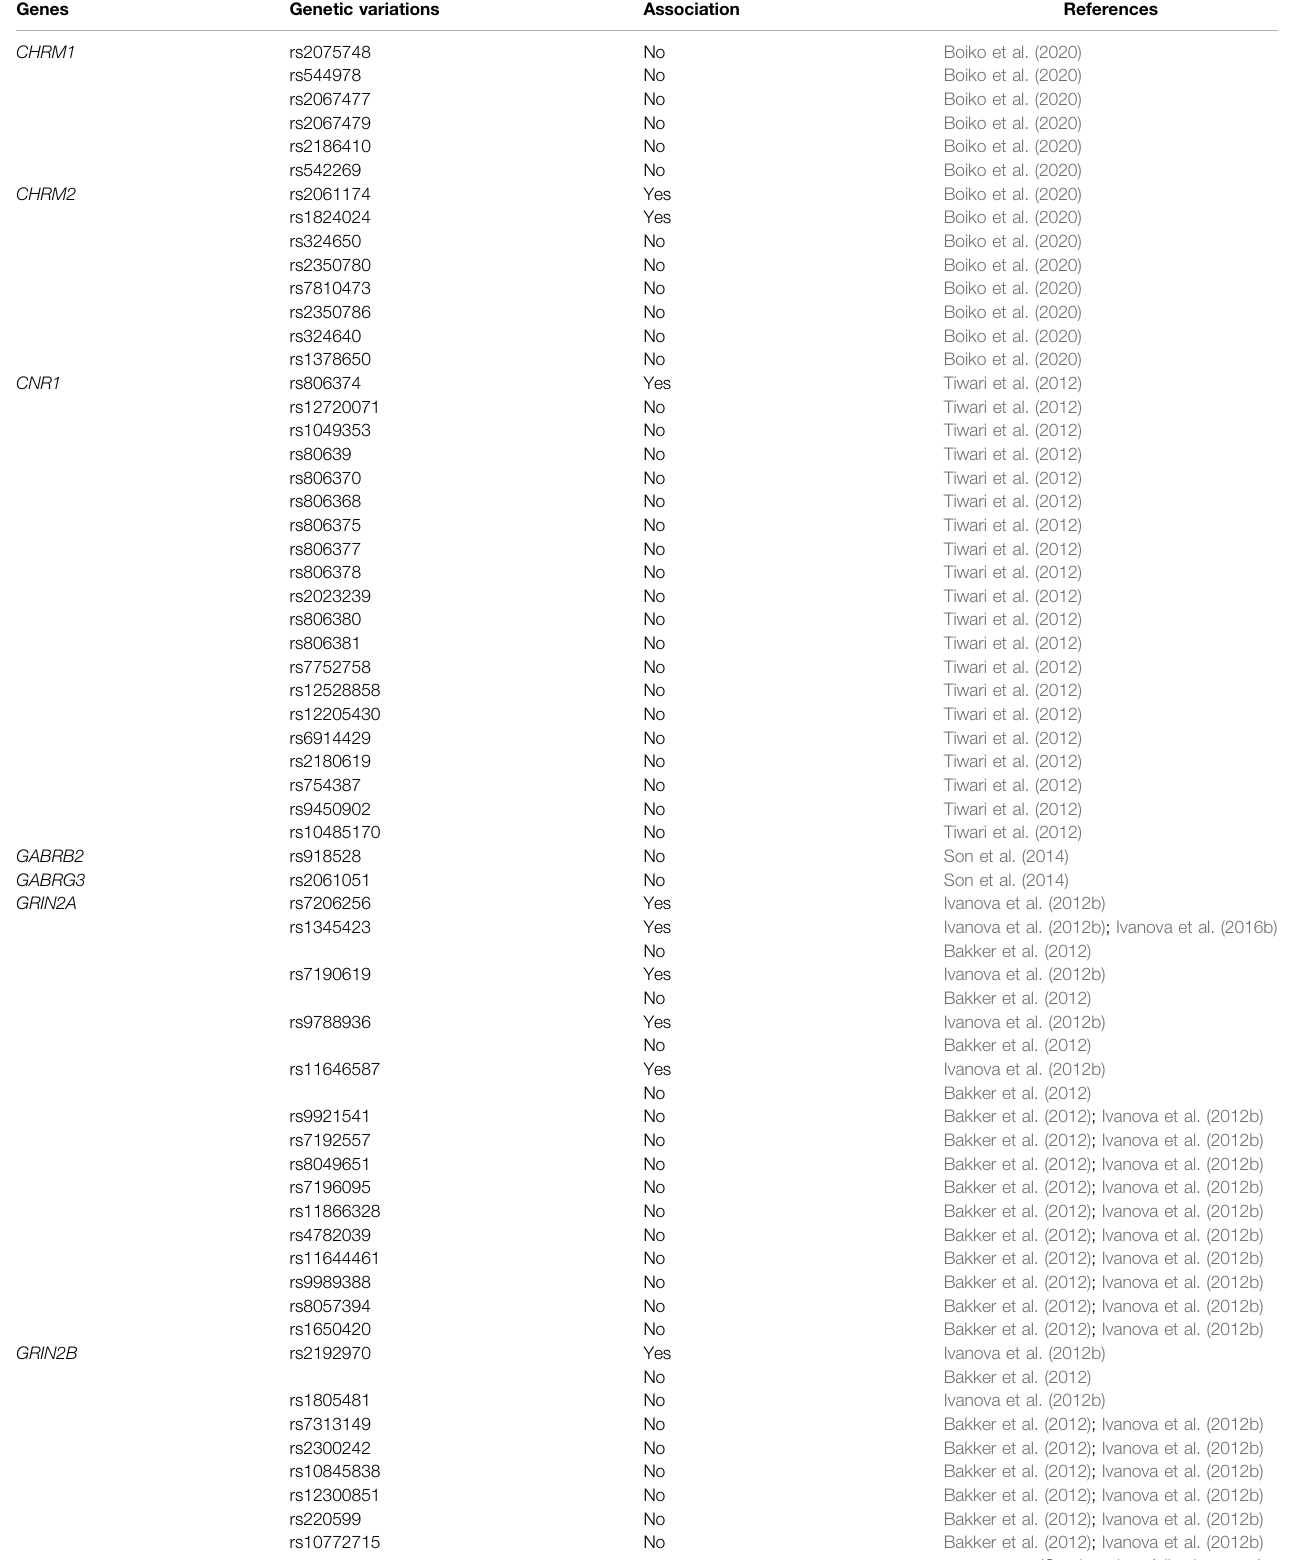
TABLE 4 | Genetic variability of other neurotransmitter receptors and their association with TD.